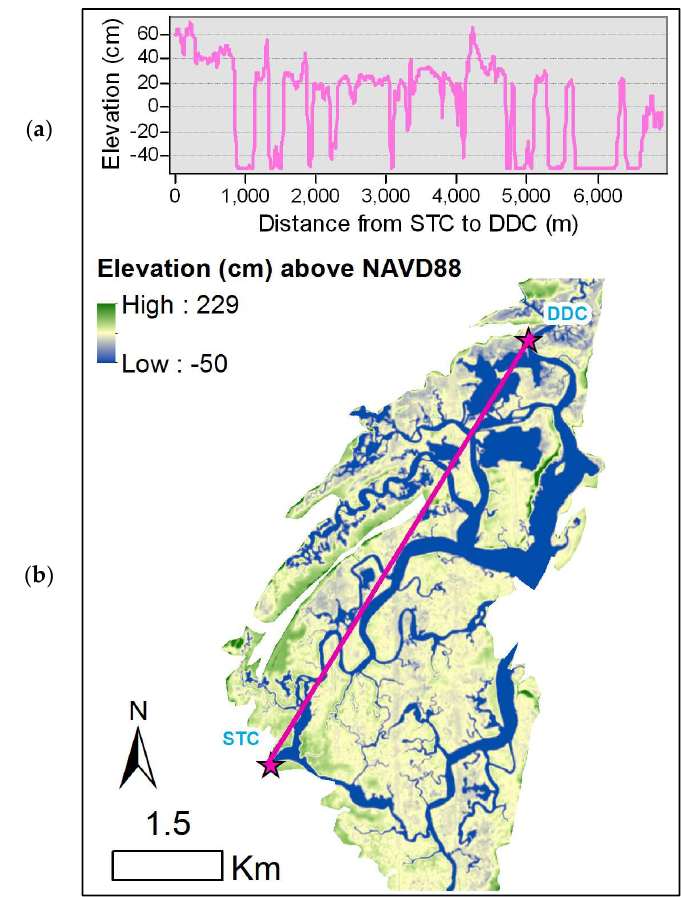
Figure 9. Elevation within North Inlet: ( a ) Elevation profile across the estuary from the southernmost sample site (STC) to the northernmost site (DDC) and ( b ) elevation (cm) above NAVD88 with a pink line representing the transect shown in (a).